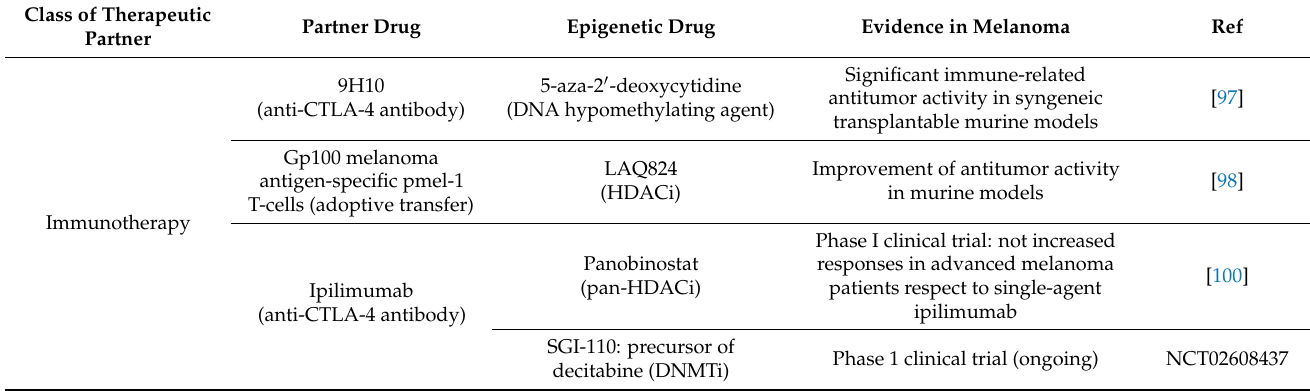
Table 2. Association of epigenetic drug with other therapeutic classes in preclinical melanoma models and melanoma patients. Abbreviations: HDACi, histone deacetylase inhibitor; DNMTi, DNA methyltransferase inhibitor. Class of Therapeutic